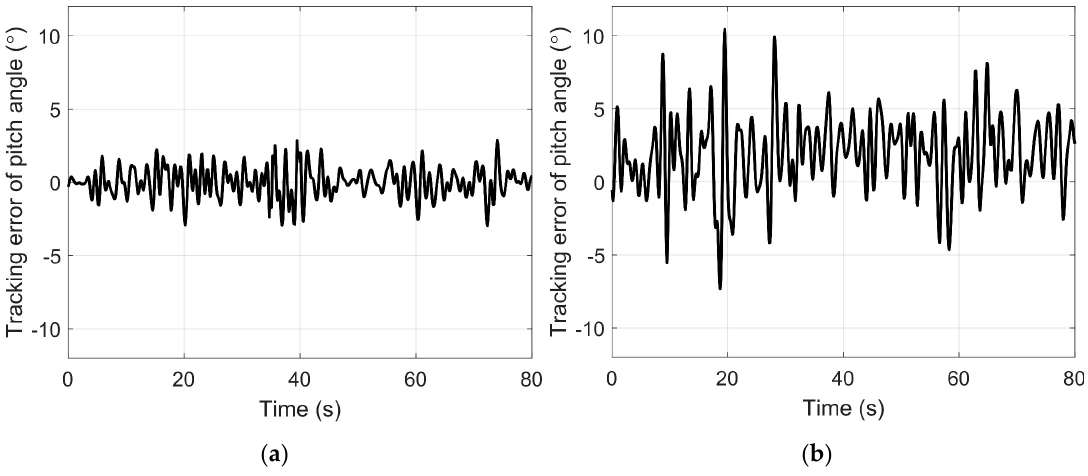
Figure 30. Tracking errors of pitch angle using different control schemes: ( a ) FTADRC; ( b ) conventional ADRC.